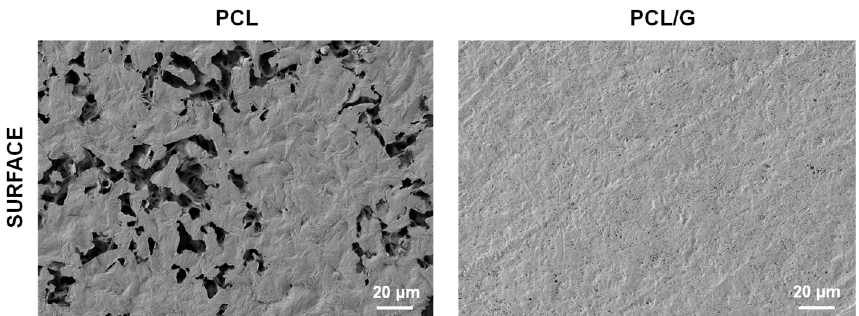
Figure 1. FESEM images of the surface of neat PCL and nanocomposites with 0.7 wt% of G nanosheets